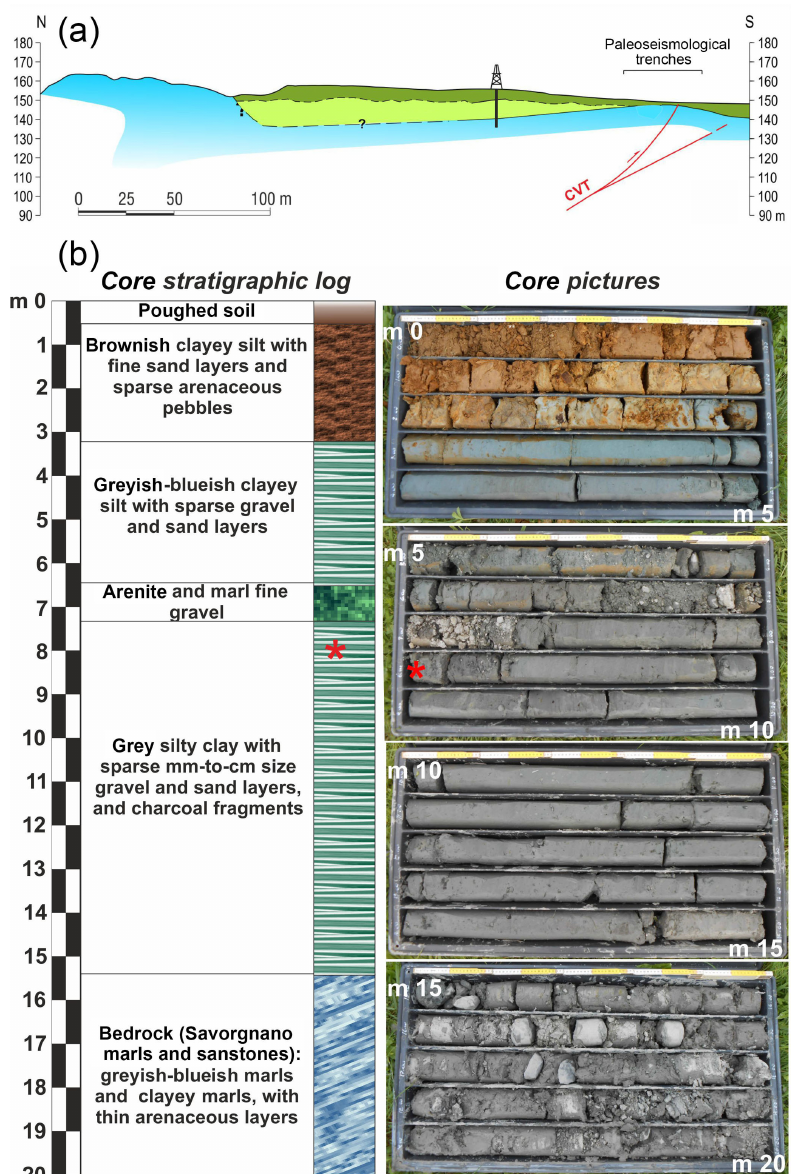
Figure 4. Geological cross section across the core logging and the paleoseismological trenches. The light green lacustrine clay does not crop out in the trenches but onlaps the growing anticline built in the turbiditic bedrock (light blue). Dark green: alluvial and colluvial deposits; light green: lacustrine deposits; blue: turbidite bedrock. In the lower panel, the stratigraphic log and pictures of the borehole. The red asterisk indicates the location of the sample which gave a radiocarbon age >45000 years. Borehole location: 46 ◦ 09 (cid:48) 07 (cid:48)(cid:48) N, 13 ◦ 18 (cid:48) 28 (cid:48)(cid:48) E